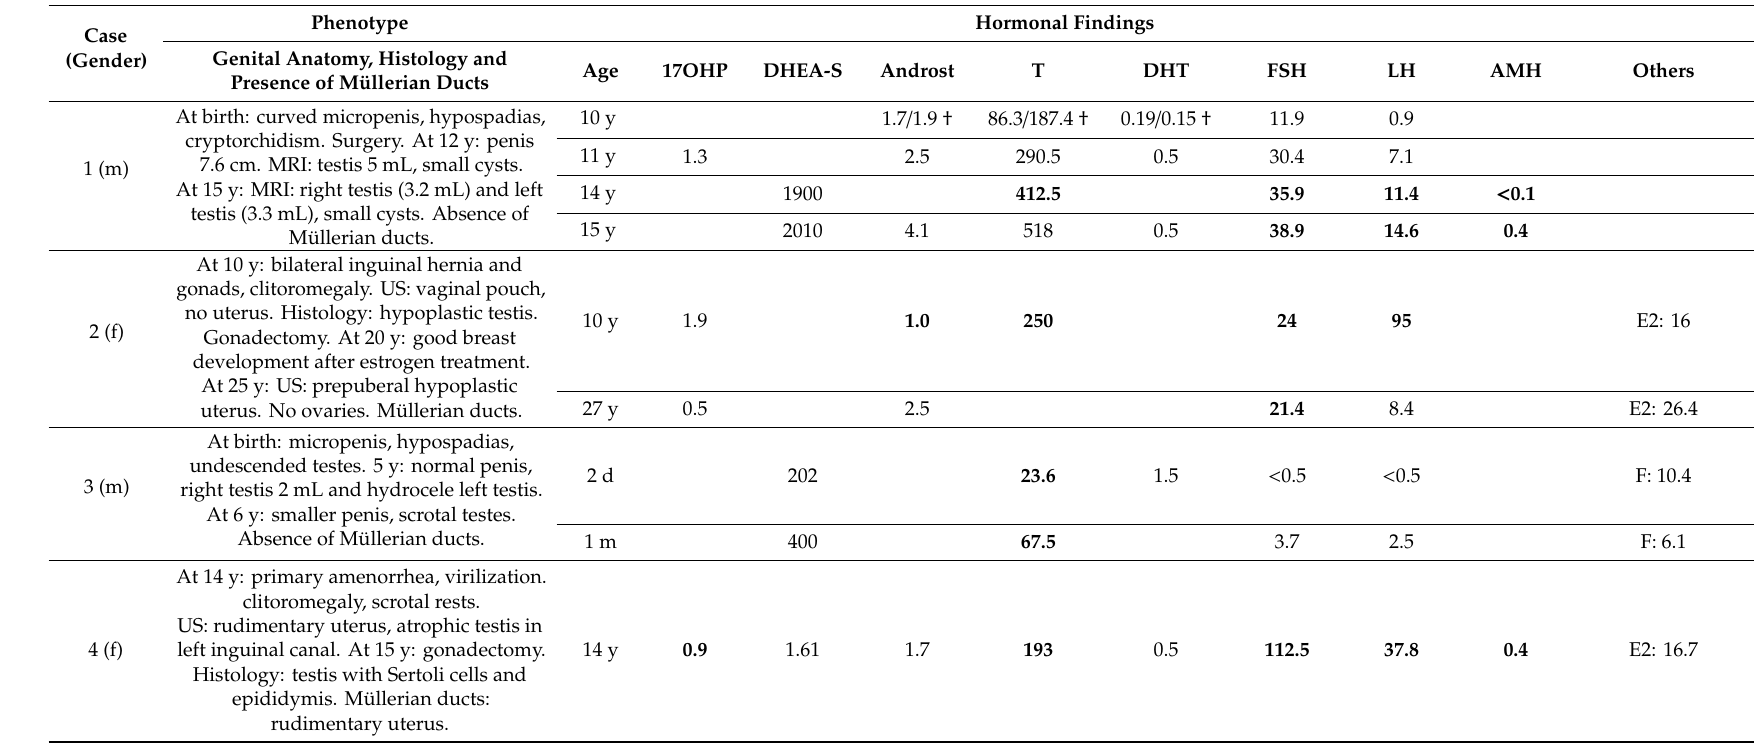
Table 1. Clinical and biochemical characteristics of the studied